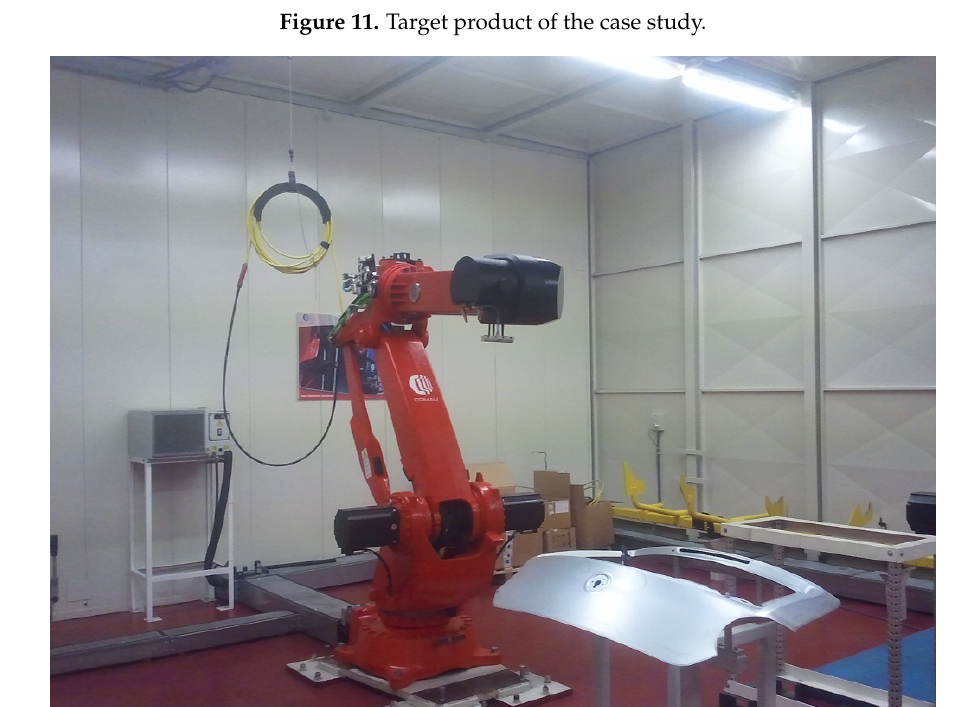
Figure 12. Experimental setting for RLW